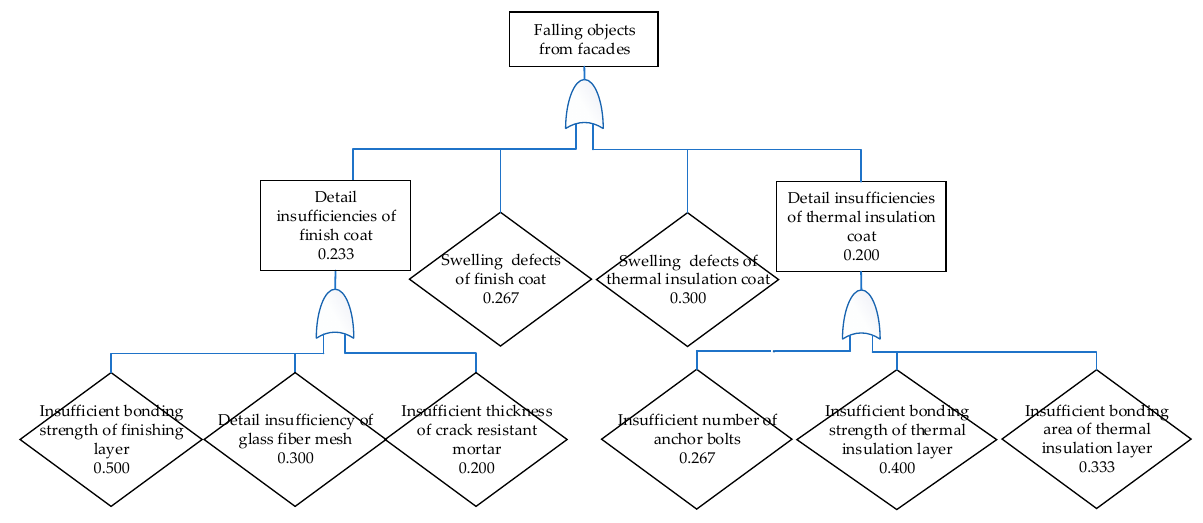
Table 3. Probability distribution parameters of elementary risk events of falling objects from façade. Figure 15. Risk assessment system of falling objects from façade. Figure 15. Risk assessment system of falling objects from façade. (2)